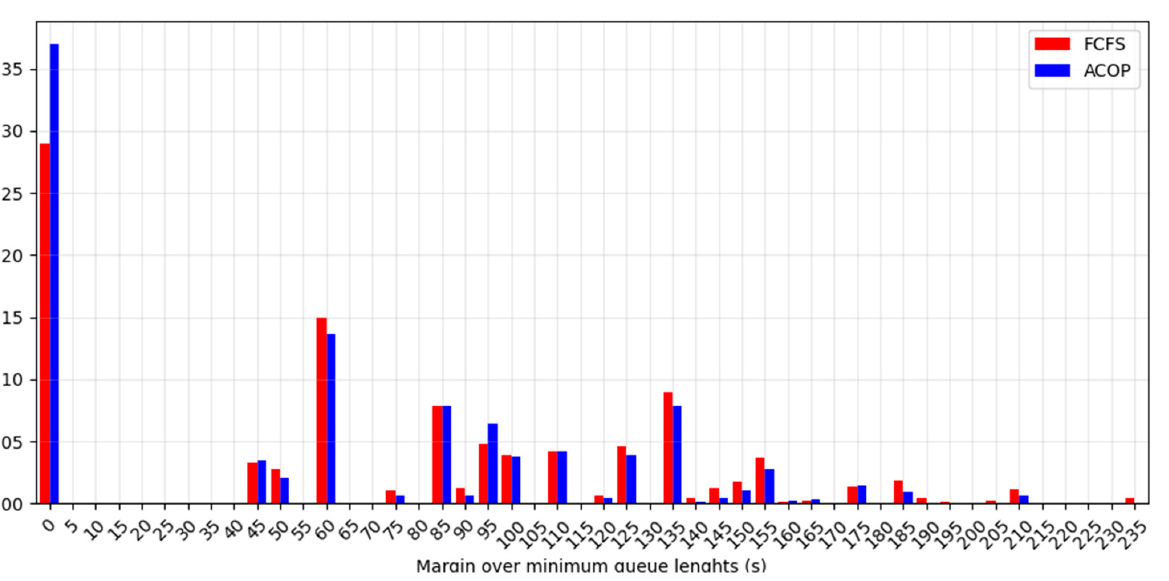
Figure 10. Time margins with respect to the optimal queue lengths.